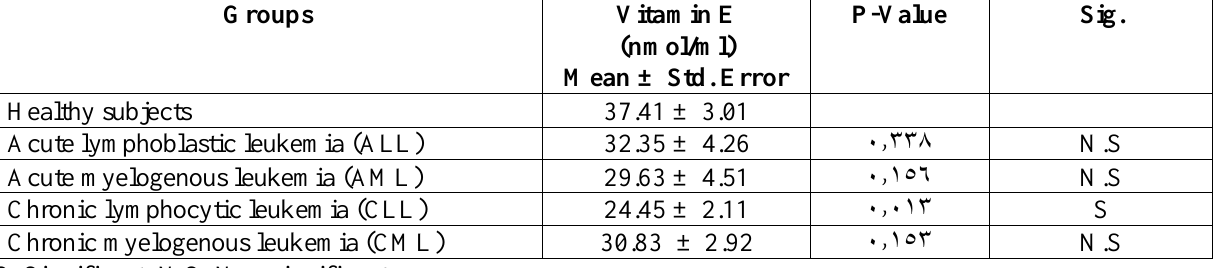
Figure 2: Vitamin E levels in the serum of leukemia patients and healthy subjects. Table 5: Serum levels of vitamin E (Mean±SE) in different types of leukemia and healthy subjects’